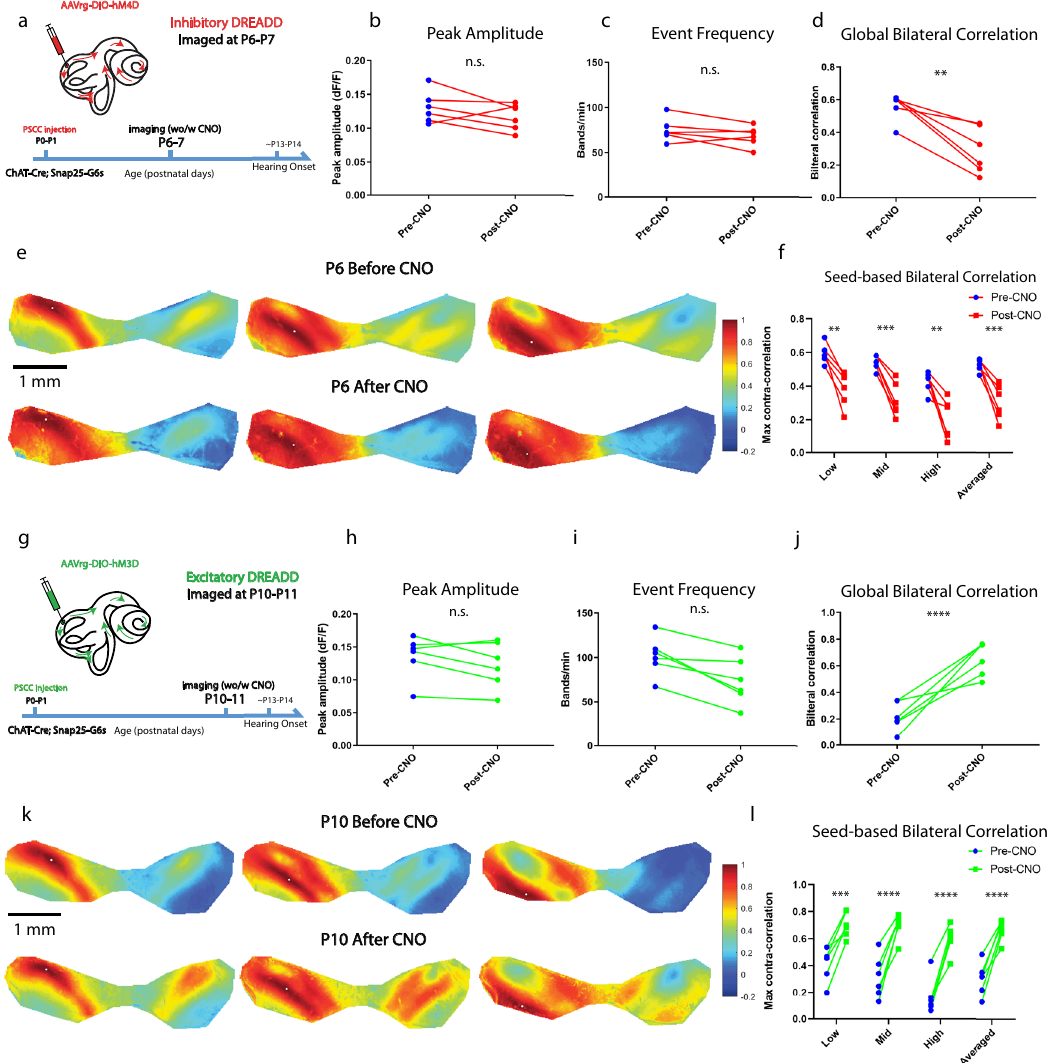
Fig. 4 Chemogenetic manipulations can suppress or enhance bilateral coupling in vivo. a Schematic showing post semicircular canal (PSCC) injection in ChAT-Cre;Snap25-G6s animals and the timeline of inhibitory chemogenetic experiments. CNO binding to hM4Di receptors (inhibitory muscarinic M 4 receptor-based Gi-coupled DREADD) expressed using a retrograde virus in olivocochlear neurons leads to inhibition of cochlear efferents. b Average peak amplitude. Similar to Fig. 1d. c Event frequency. Similar to Fig. 1e. d Global bilateral correlation. Similar to Fig. 1j. e Example correlation maps showing correlation patterns in the IC before and after CNO injection from the same animal at P6. Top panels: before CNO. Bottom panels: after CNO. Three typical representative seeds (white dots) located in the future low-, mid-, and high-frequency regions. f Seed-based bilateral correlation. Similar to Fig. 1k. g Similar to ( a ) but imaged at P10 – P11 for excitatory chemogenetic experiments. CNO binding to retrograde virus-expressed hM3Dq receptors (excitatory muscarinic M 3 receptor-based Gq-coupled DREADD) in olivocochlear neurons leads to efferent neuron excitation. h Similar to ( b ) for excitatory chemogenetic experiments. i Similar to ( c ) for excitatory chemogenetic experiments. j Similar to ( d ) for excitatory chemogenetic experiments. k Similar to ( e ) but with an example animal at P10 for excitatory chemogenetic experiments. l Similar to ( f ) for excitatory chemogenetic experiments. Inhibitory DREADD experiments: number of animals = 6; theme color: Red. All imaged at P6 – P7. Excitatory DREADD experiments: number of animals = 6; theme color: Green. All imaged at P10 – P11. n.s. p >0.05, ∗ p